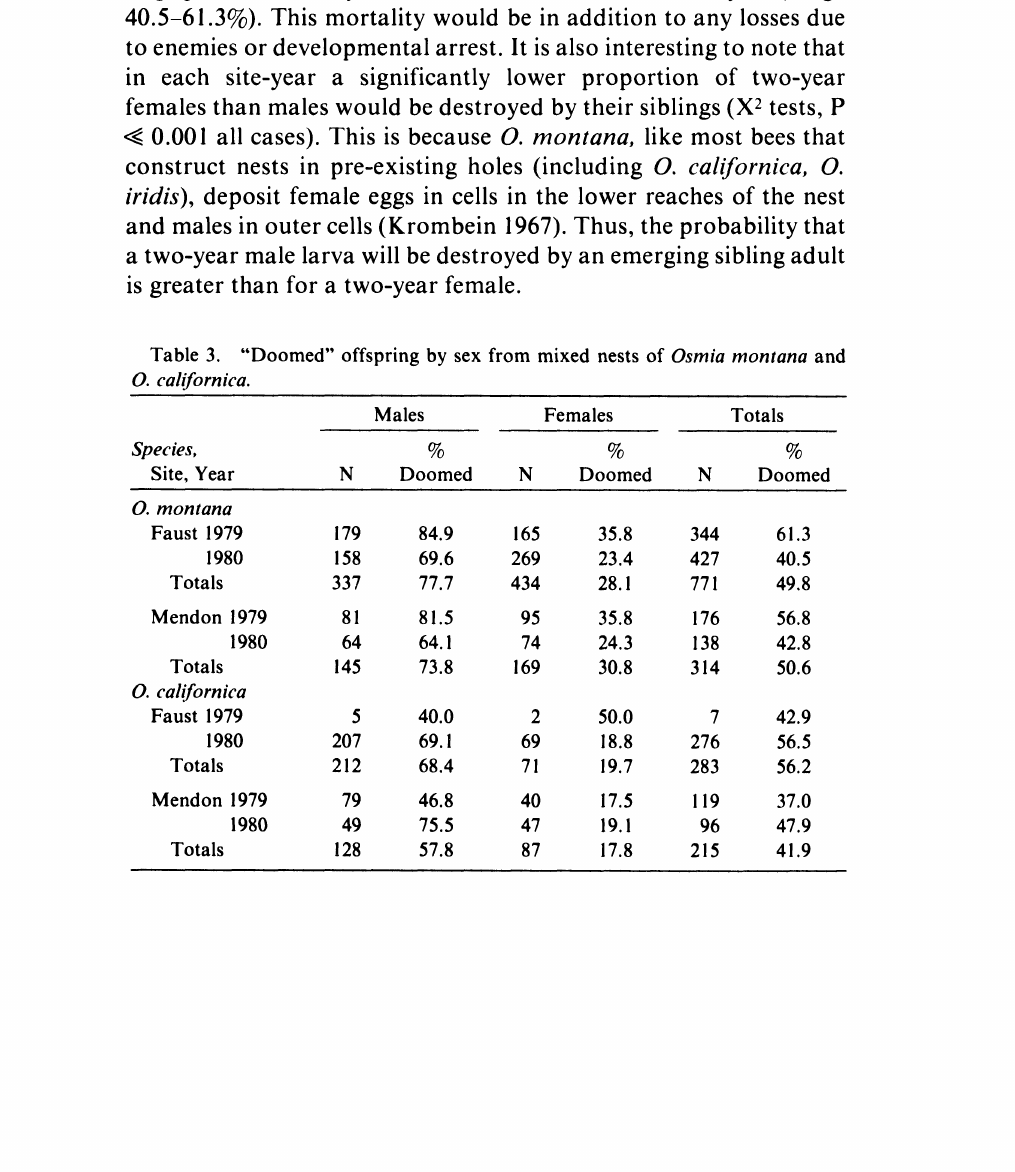
Table 3. "Doomed" offspring by sex from mixed nests of Osmia montana and O. californica. Males Females Totals Species, % % Site, Year N Doomed N Doomed N O. montana Faust